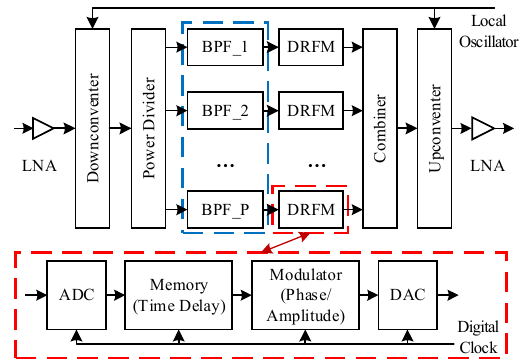
Figure 4. The signal processing flow of the jamming model.